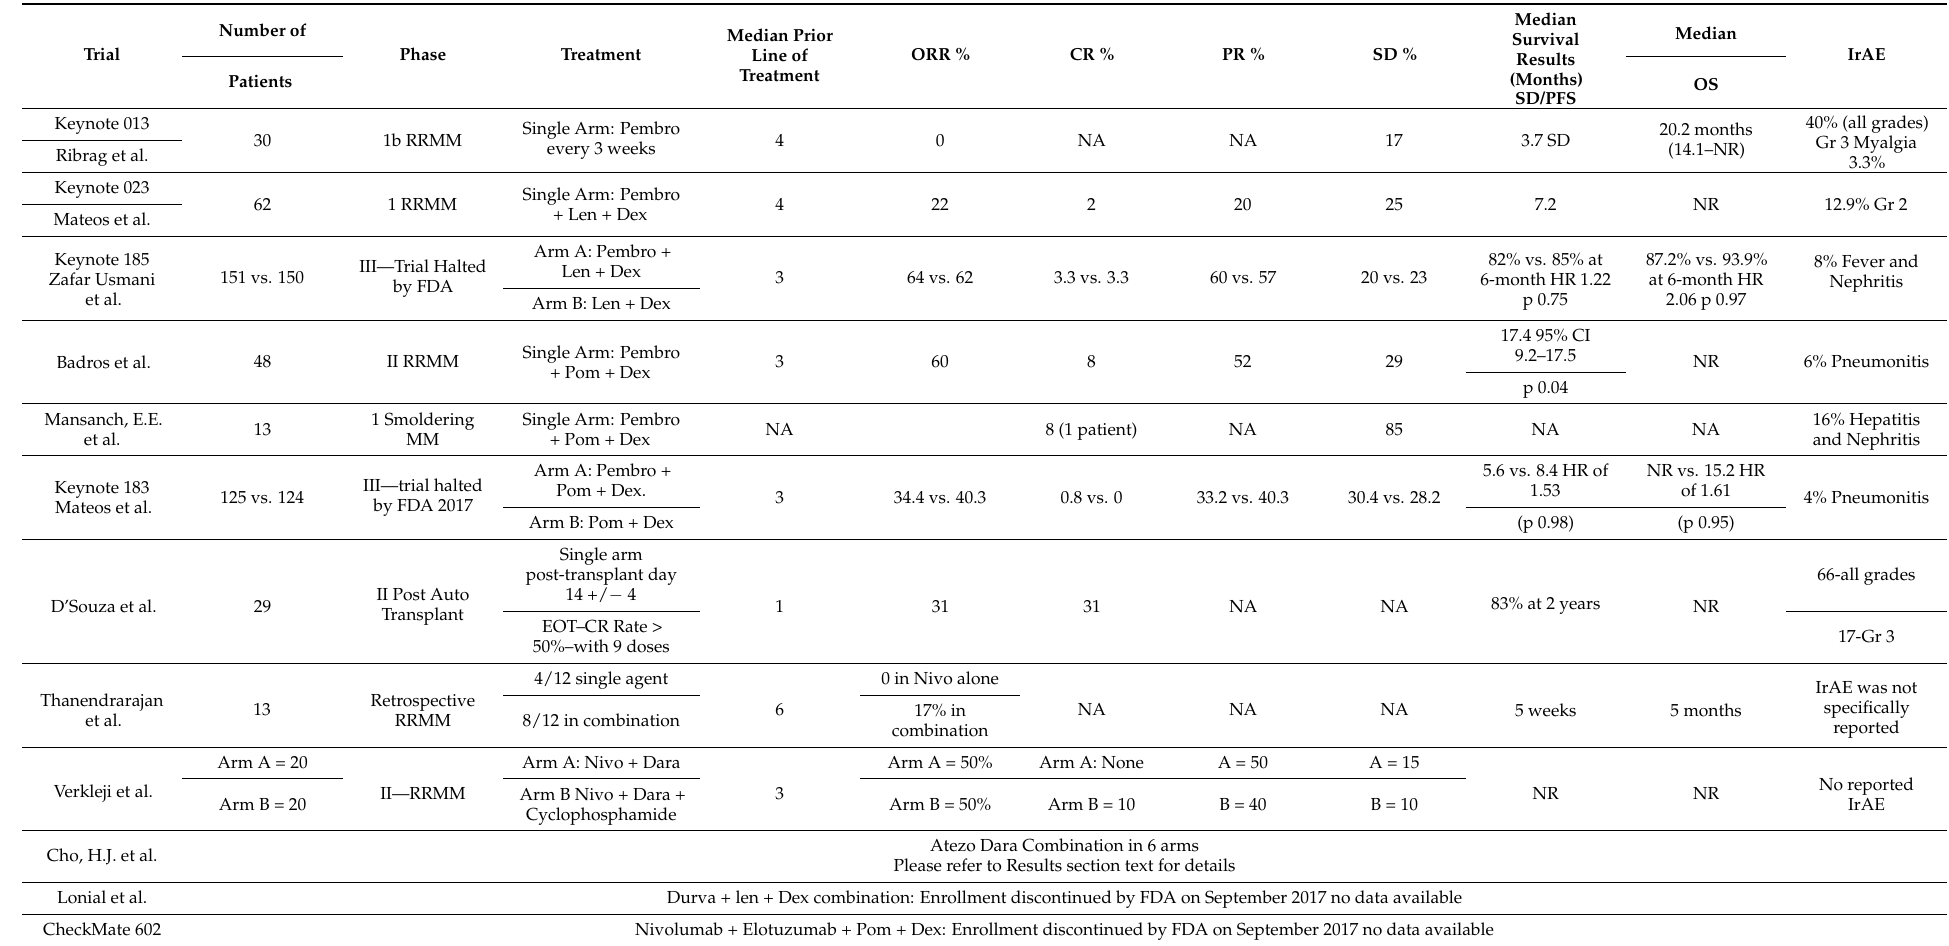
Table 1. Clinical Trial Results with PD-1/PD-L1 in Multiple